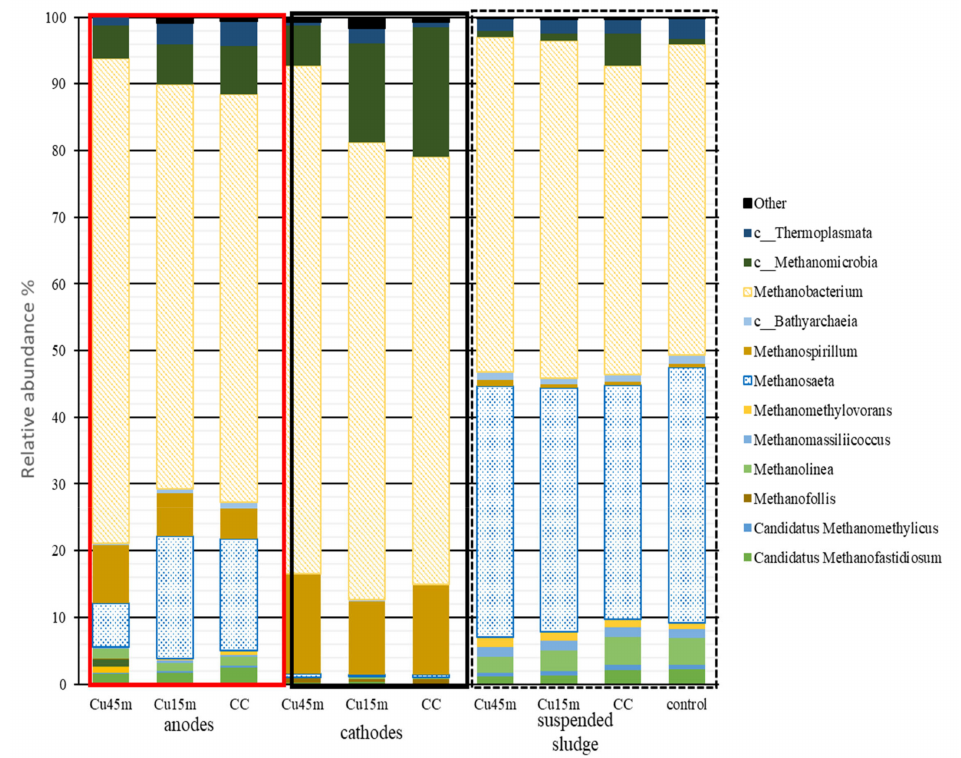
Figure 10. Archaea relative abundance % at a genus level. Genus had a relative abundance <0.5% were assigned to “others”. Sample nomenclature: Cu45min: Carbon cloth deposited with copper nanoparticles for 45 min, Cu15min: Carbon cloth electrode deposited with copper nanoparticles for 15 min, CC: carbon cloth electrode, Control: serum bottle inoculated with anaerobic granular sludge no